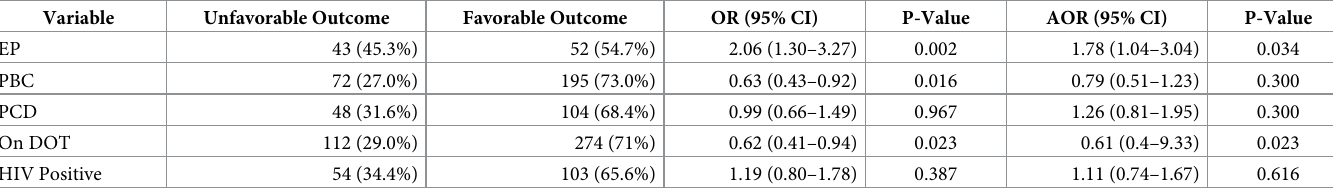
Table 6. Risk of unfavorable outcomes of TB Treatment among the elderly by patient category. Variable